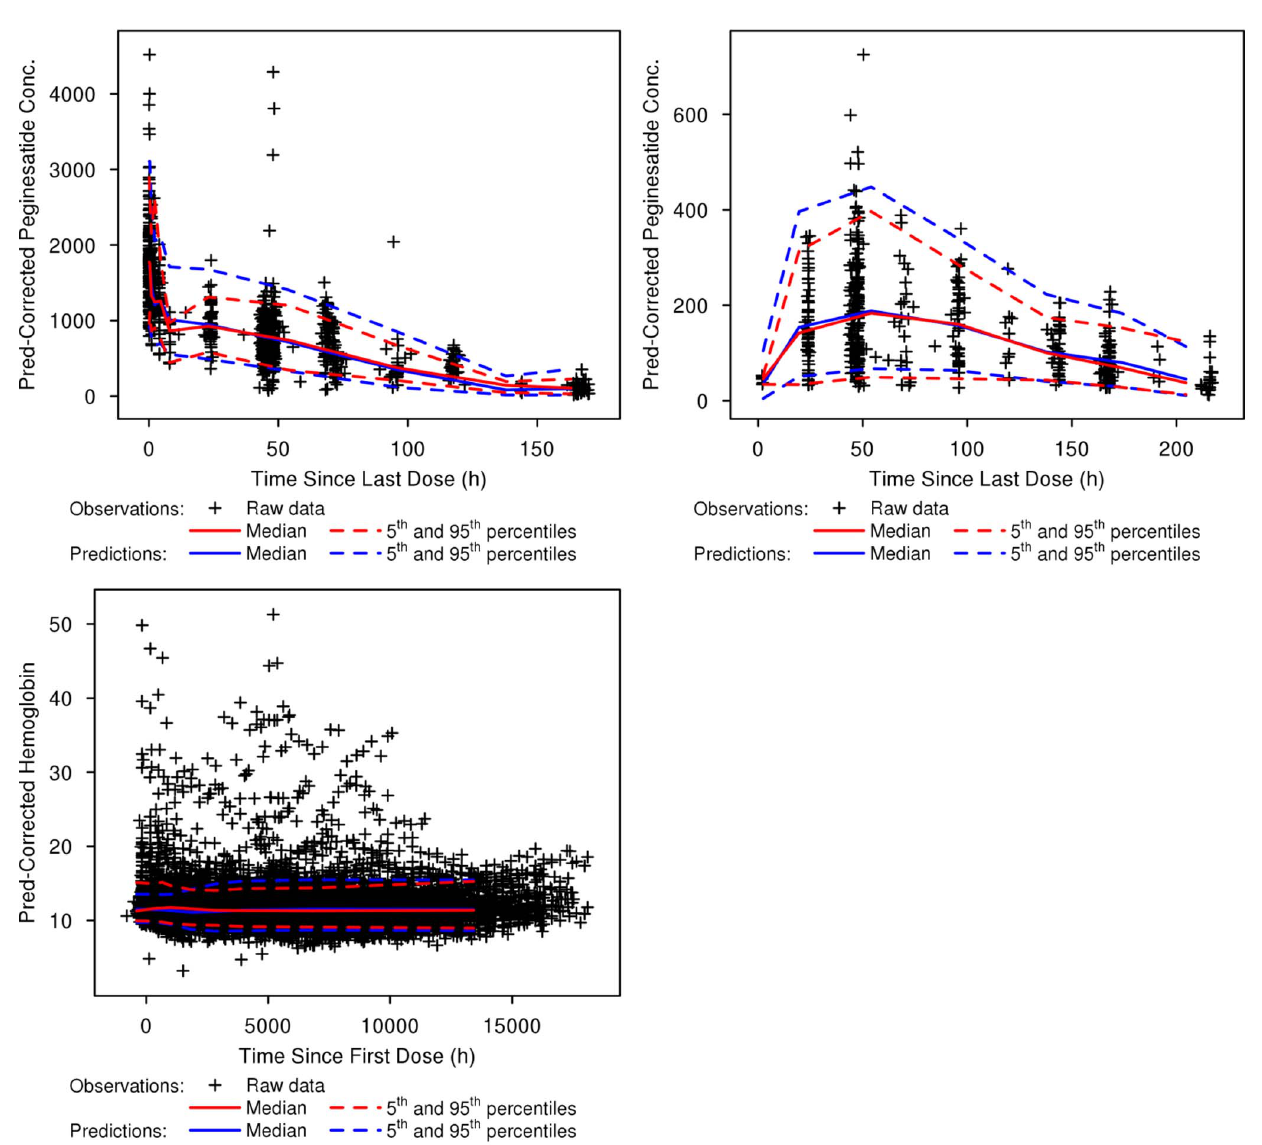
Figure 3. Prediction-corrected visual predictive checks for the final PK model of peginesatide following intravenous and subcutaneous dosing and the final PK-PD model of predicted hemoglobin levels. Upper left: visual predictive check for peginesatide PK model following intravenous administration; Upper right: visual predictive check for peginesatide PK model following subcutaneous administration; Lower panel: visual predictive check for hemoglobin based on final population PK-PD model for peginesatide.